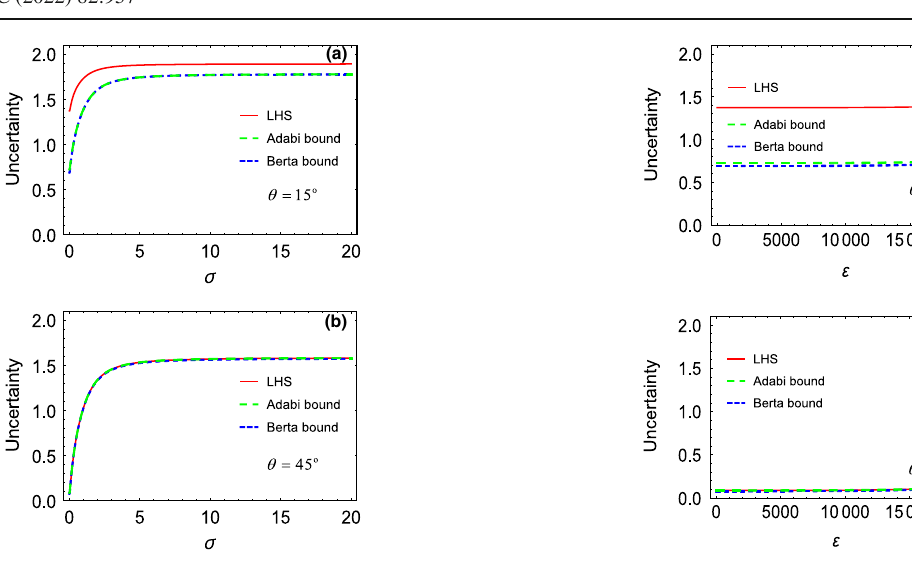
= μ = 0 . 1, and m = 0 . A B